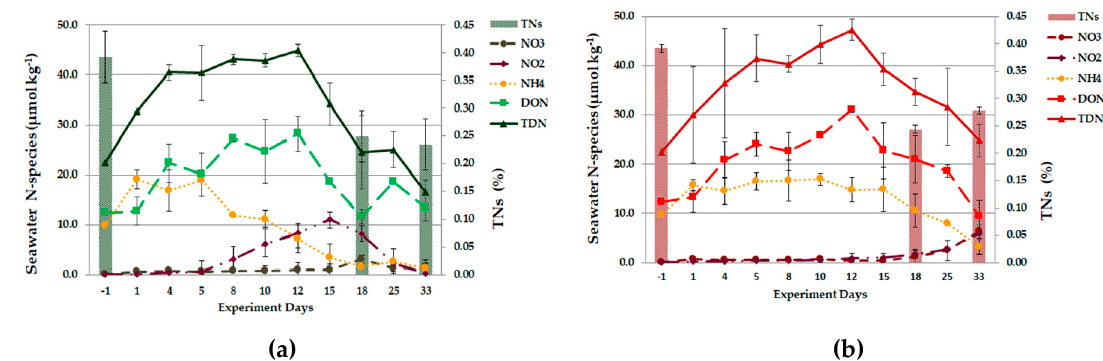
Figure 8. Nitrate, nitrite, ammonium, DON concentrations (in μ mol kg − 1 ) and sedimentary TN (in %) for the duration of the experiment for ( a ) C and ( b ) OA conditions (x-axis: days of the experiment; mean values and standard deviations for the two replicates of each treatment.